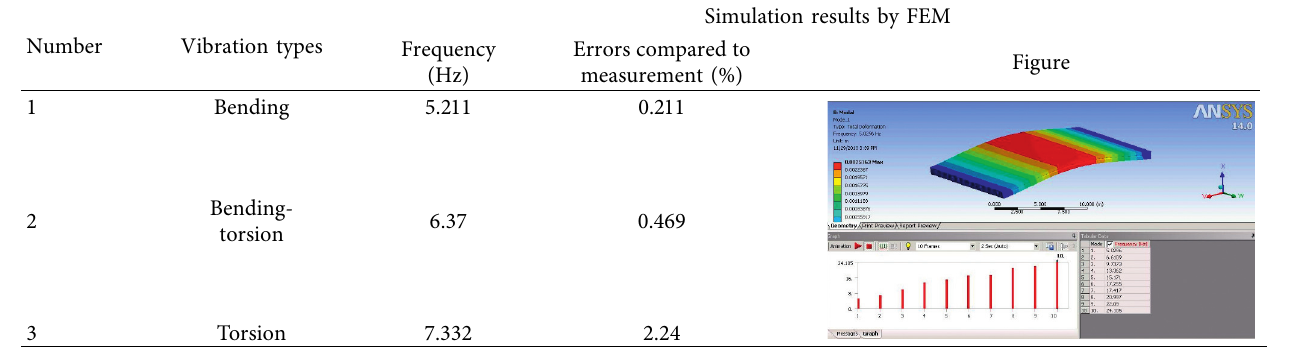
Table 7: The numerical simulation using finite element method at Binh Phuoc 2 flyover.